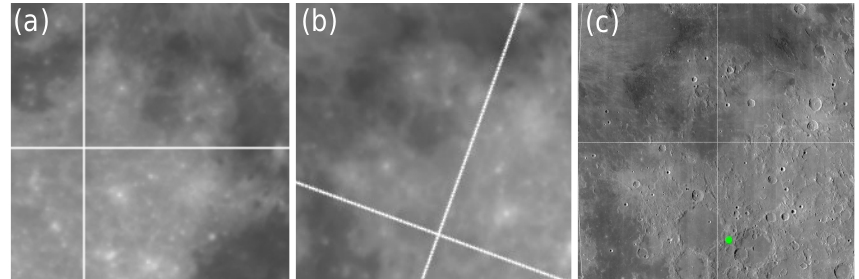
Figure 7. An example of the determination of the IC lunar coordinates with the program Virtual Moon. (a) Clipping of the ROLO image “mm194407” including the adjusted boundaries of the four quadrants in the SFD simulation. (b) is panel (a) rotated by about 70 ◦ counter- clockwise to match the orientation of the moon in Virtual Moon. (c) The same area as the image in Virtual Moon. The intensity centre in the Ptolemaeus crater region is marked by the green dot. The shown region in (b) and (a) corresponds to the one used in Fig. 8.